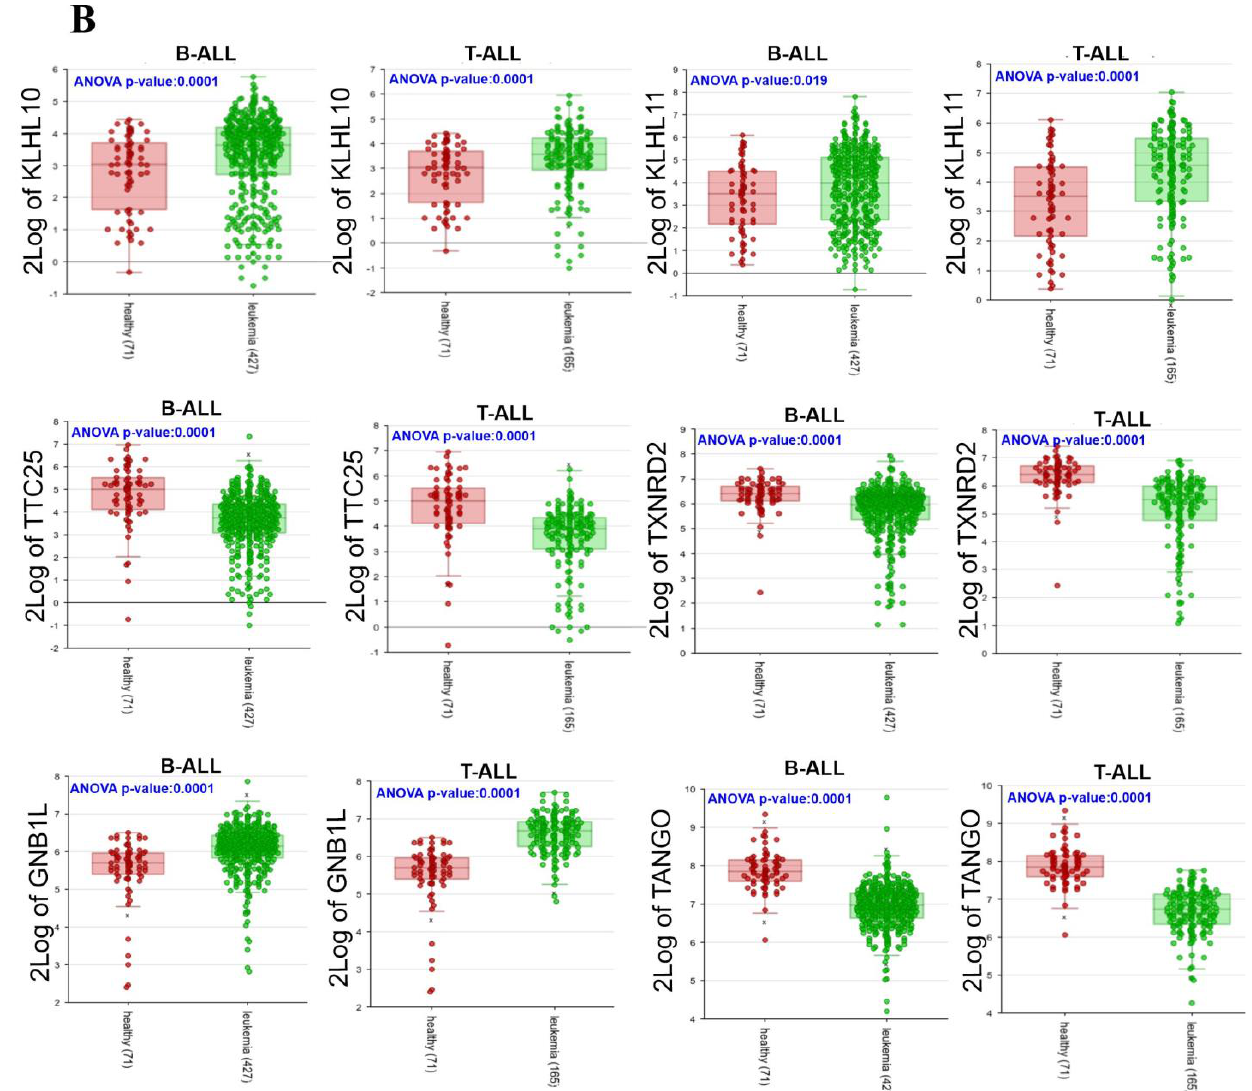
Figure 6. ( A , B ) Expressions of gain region genes in healthy individuals compared with ALL patients. Analysis of each gene was performed using the MILE project dataset. Boxplots show expressions at the RNA level in B-ALL or T-ALL subtypes, including ANOVA p -values. Numbers shown in parentheses correspond to the number of individuals analyzed for each gene. 2Log: gene expression transformed into logarithm with base 2.